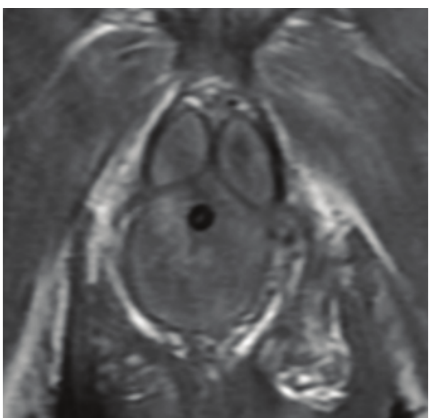
Figure 1: A representative MRI T1 image without gadolinium show- ingacoronalcutofthebaseofthepeniswithbothcorporacavernosa and the corpus spongiosum having similar signal intensity.